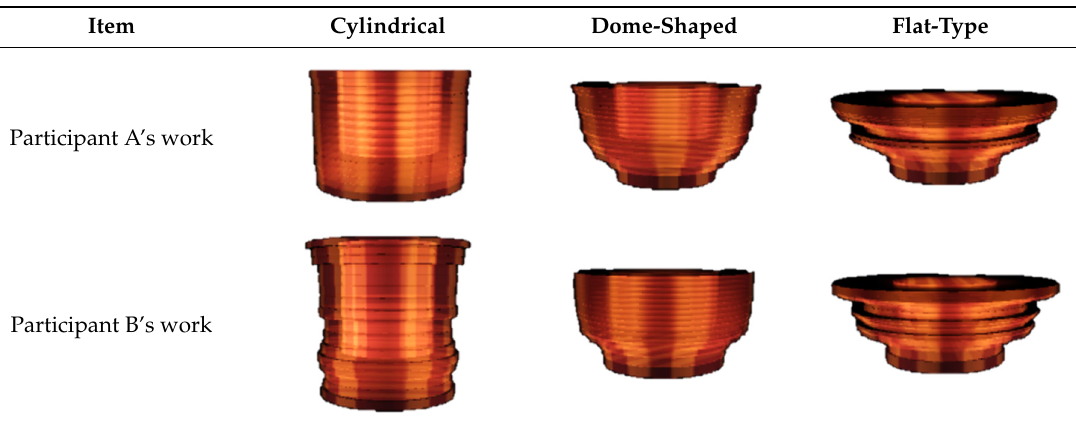
Table 6. Examples of participant’s work.